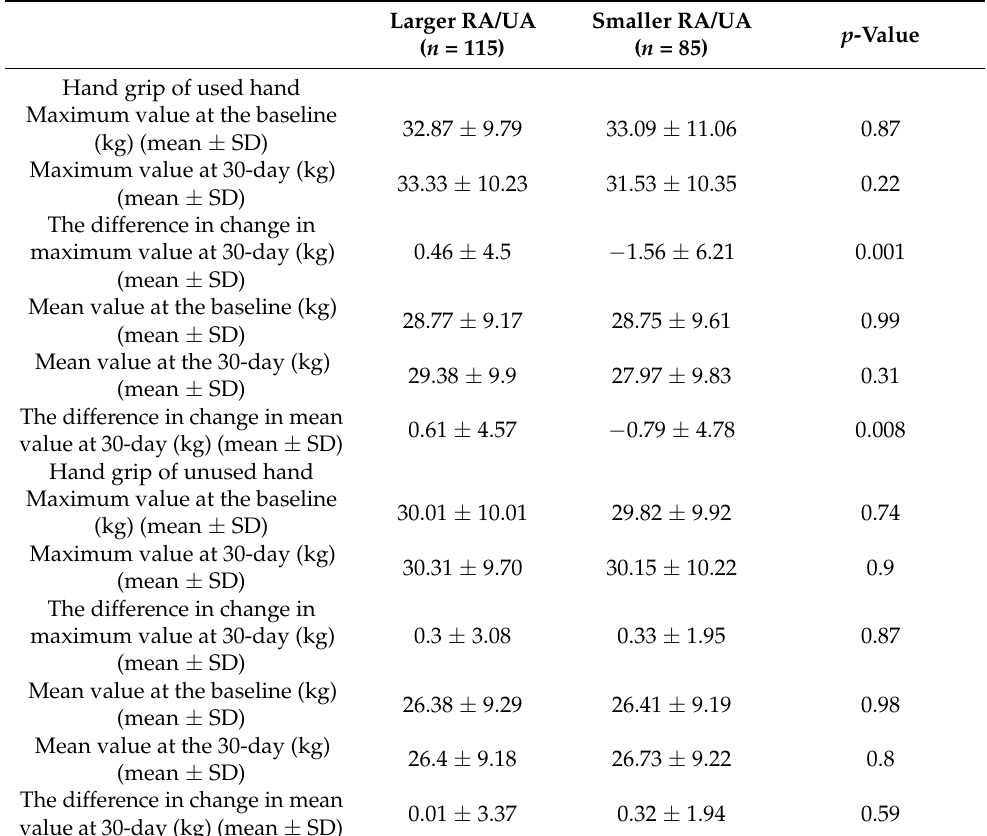
Table 4. Hand grip values and changes in the hand grip values at the baseline and at 30-day follow-up. Data of used and unused hand for coronary angiography CAG/PCI.